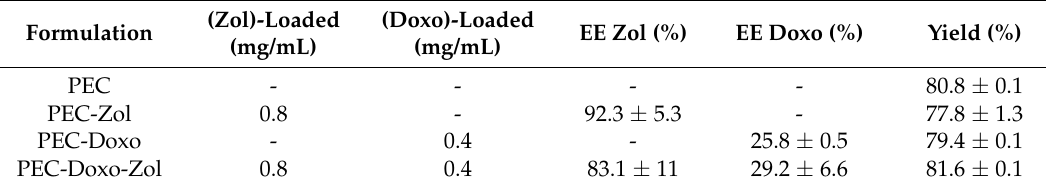
Table 4. Doxorubicin (Doxo) and zoledronic acid (Zol) encapsulation efficiency (EE) (%) and yield (%) of different formulations prepared. All results are expressed as mean ± SD of at least three independent experiments.